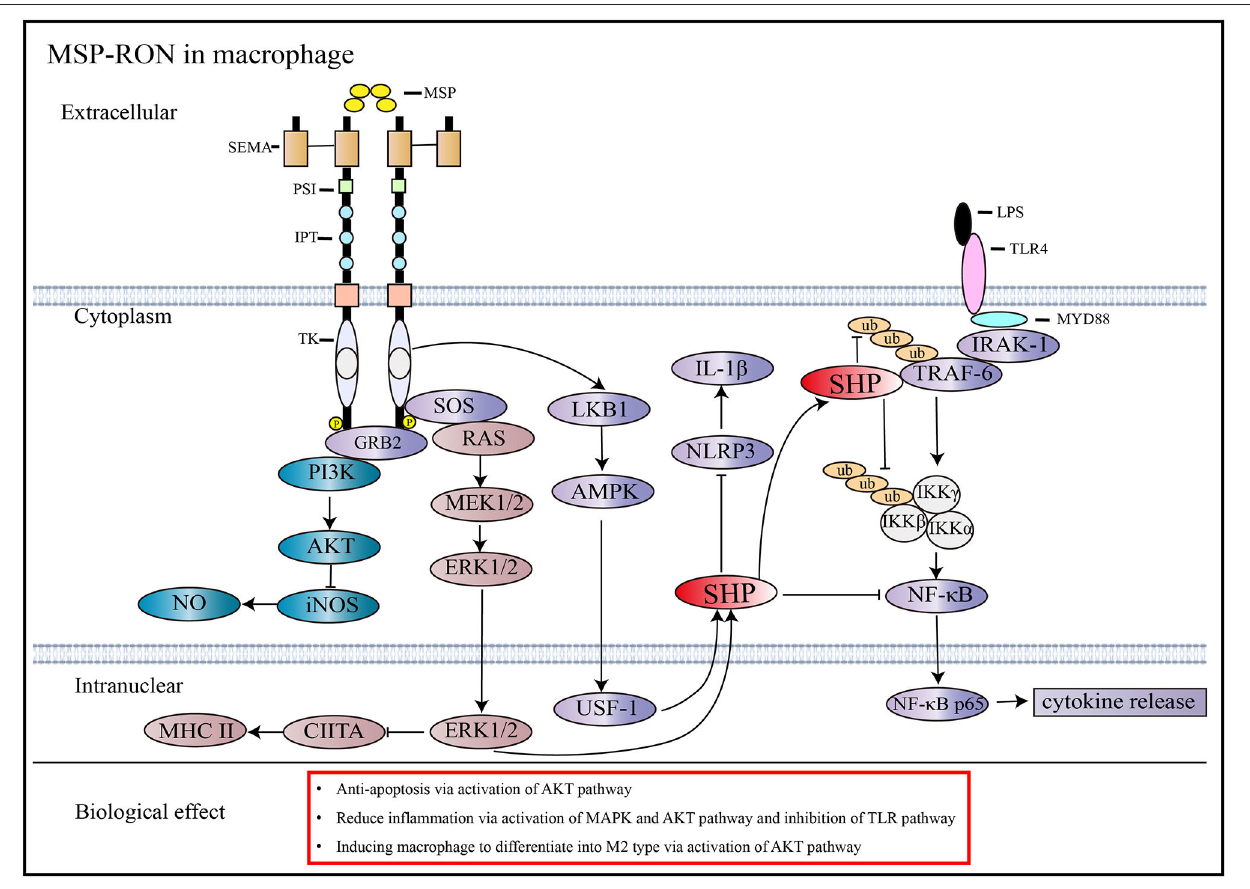
FIGURE 2 | Signaling pathways activated by MSP and RON. MSP induces RON dimerization and activates downstream pathways (13). In macrophages, the activation of RON inhibits iNOS through the AKT pathway and reduces NO synthesis (10). RON activation stimulates SHP expression through the MAPK and AMPK pathways, which can antagonize the TLR4 pathway by inhibiting TRAF6 ubiquitination and preventing NF- κ B from entering the nucleus, thus reducing cytokine production (39). Besides, increased expression of SHP through activation of the MSP-RON pathway can inhibit NLRP3 inflammasome activation, thereby inhibiting cleavage of pro-IL-1 β into activated IL-1 β (40). MSP-RON activation also inhibits CIITA transcription and, thus, MHC II expression via the MAPK pathway